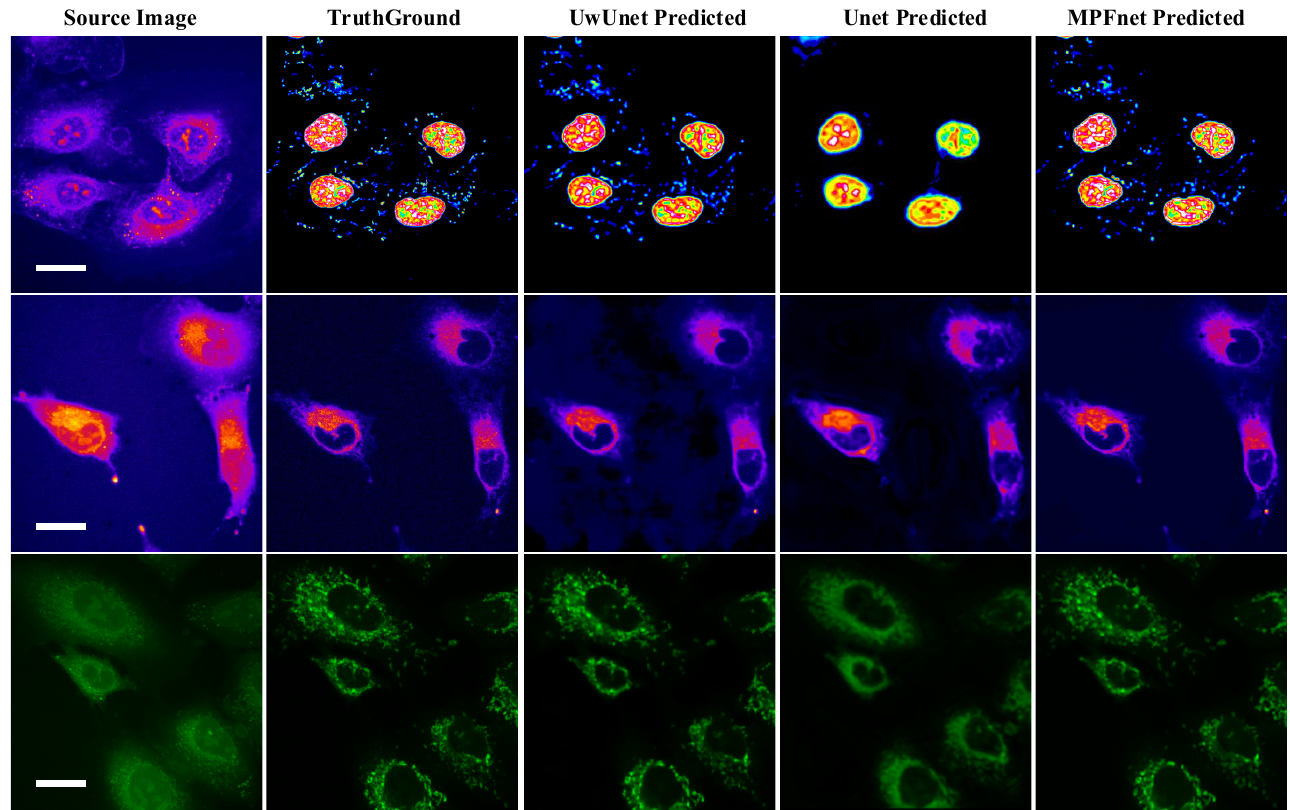
Figure 3. Predicted organelle fluorescence from hyperspectral SRS microscopy images by using UwUNet, U-Net, and MPFNet methods. The first column shows the Input SRS image, the second column shows the ground-truth fluorescence image, and the following three columns display the predicted fluorescence results by UwUNet, U-Net, and MPFNet, respectively, for nuclei ( top ), mitochondria ( middle ), and endoplasmic reticulum ( bottom ). Scale bar, 25 μm.